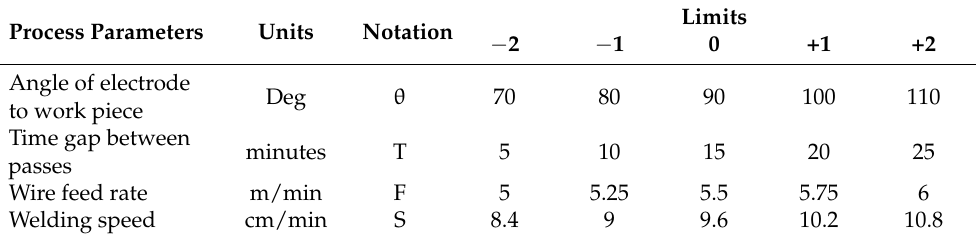
Table 2. Welding process parameters and their